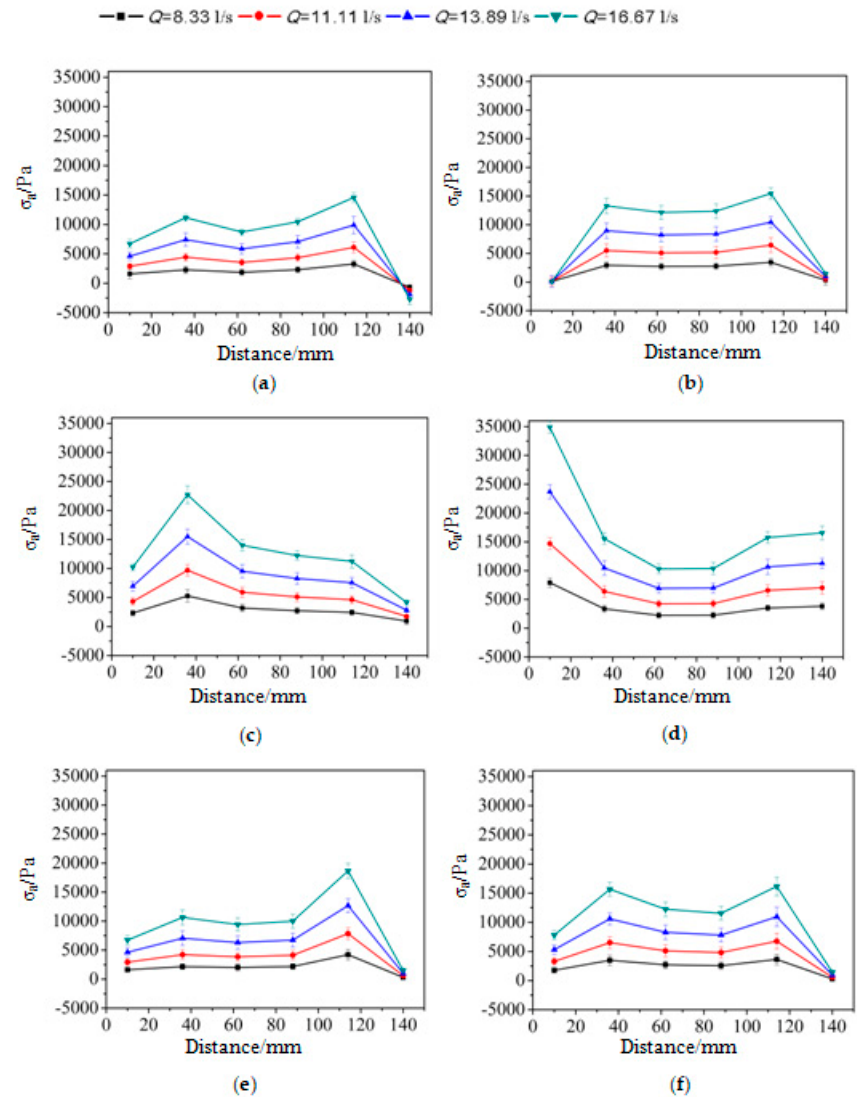
Figure 10. Principal-stress component on capsule surface. ( a ) θ = 0 ◦ ; ( b ) θ = 30 ◦ ; ( c ) θ = 60 ◦ ; ( d ) θ = Figure 10. principal-stress component on capsule surface. ( a ) θ = 0°; ( b ) θ = 30°; ( c ) θ = 60°; ( d ) θ = 90°; 90 ◦ ; ( e ) θ = 120 ◦ ; ( f ) θ = 150 ◦ ( e ) θ = 120°; ( f ) θ = 150°.